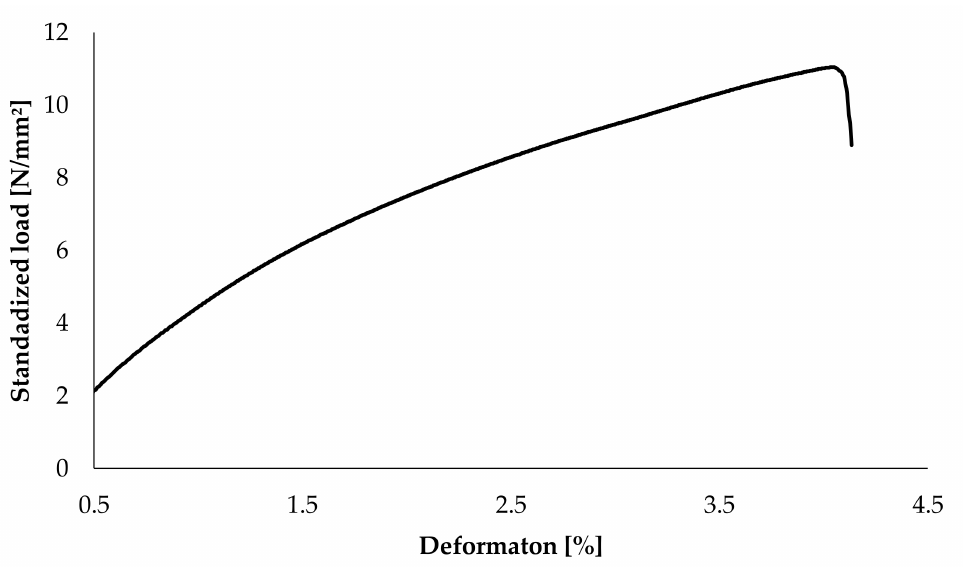
Figure 8. Typical load displacement curve of a group C test